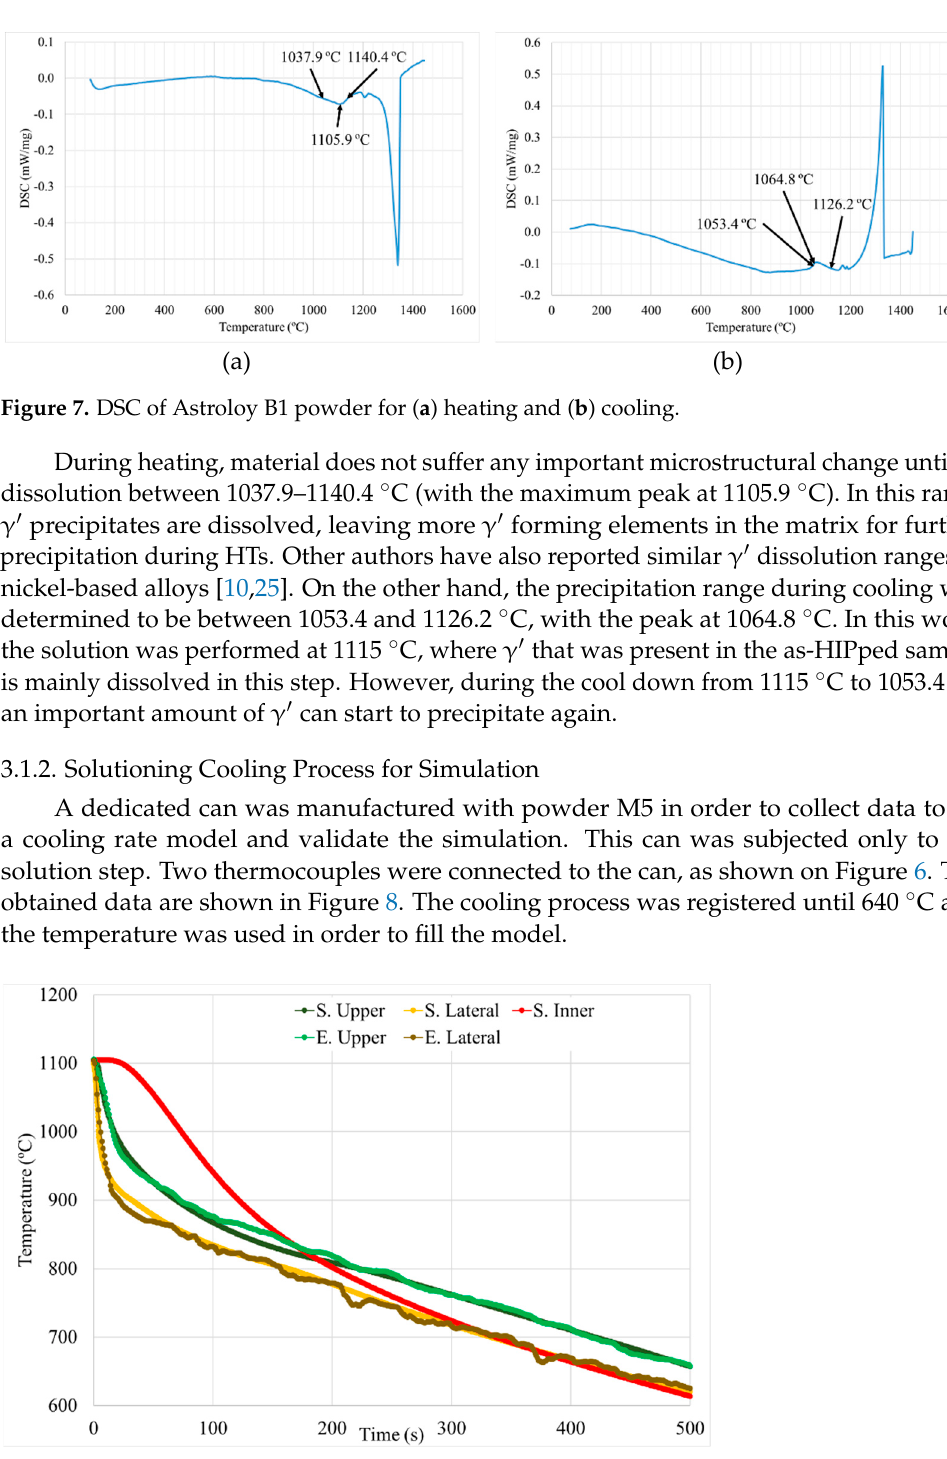
Figure 8. Solution cooling process of the powder M5 can, experimental (E) and simulated results (S). Simulation process curves fit well with the original ones (see Figure 8). The cooling rates of the three studied areas were obtained from these curves. The cooling rates